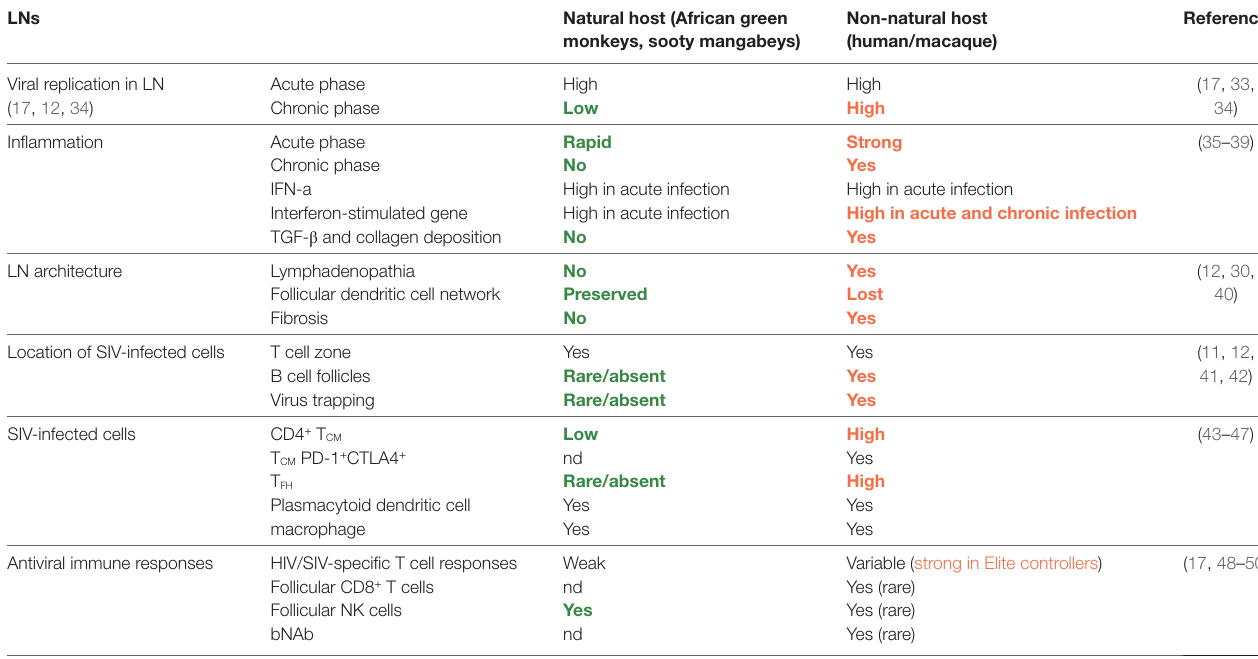
TabLe 1 | Major similarities and differences between HIV/SIVmac infections and SIV infections in natural hosts at the level of lymph nodes (LNs). LNs Natural host (african green Non-natural host monkeys, sooty mangabeys)